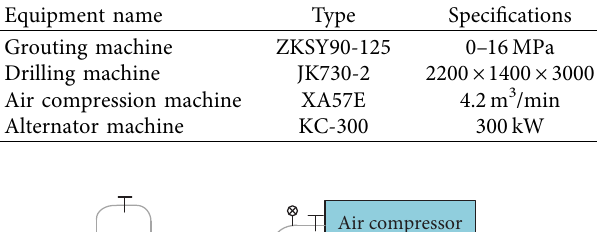
Figure 3: Grouting equipment: (a) drilling machine; (b) grouting pump; (c) air compressor. Table 3: Grouting equipment.